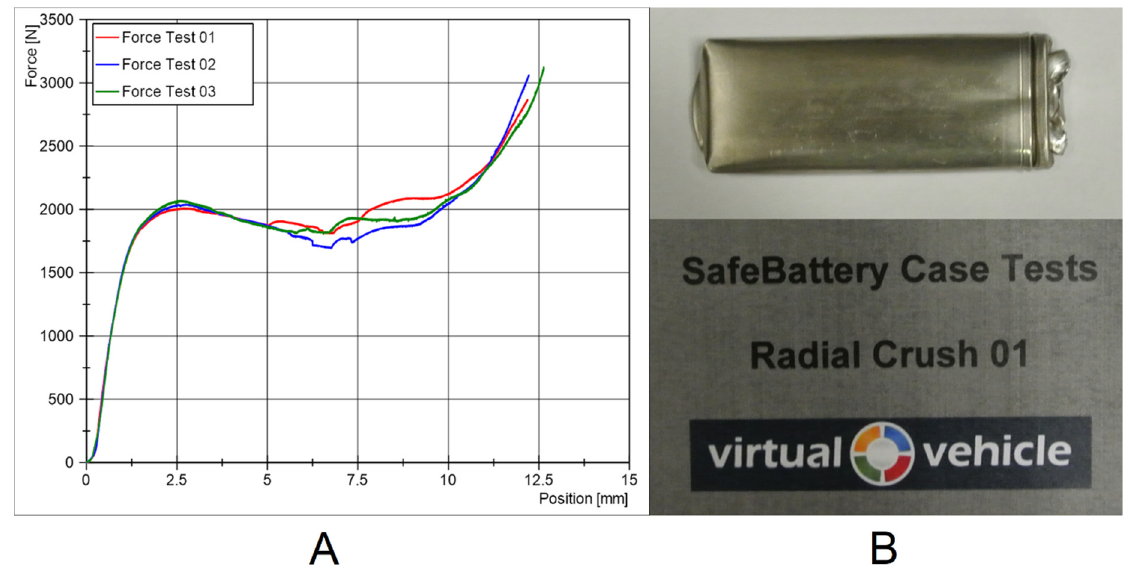
Figure A2. Results of the cell-case test for the load-case radial crush ( A ) and cell-case specimen after testing ( B ).